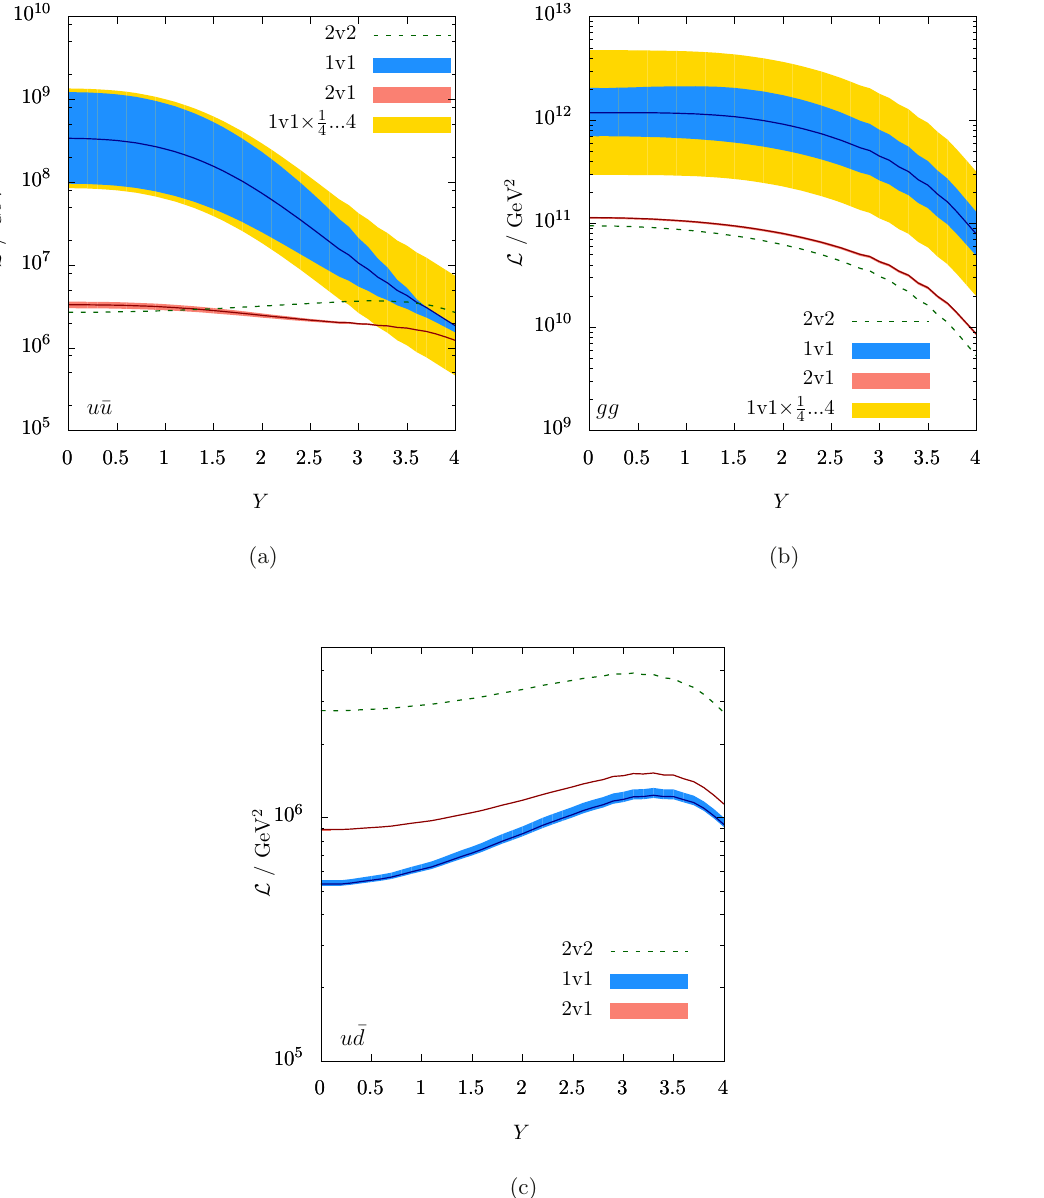
Figure 12 . Double parton scattering luminosities a 1 a 2 b 1 b 2 ( Y ) for the production of two systems L with Q 1 = Q 2 = 80 GeV at √ s = 14 TeV, one with central rapidity and the other with rapidity Y . The parton combinations a 1 a 2 b 1 b 2 are u ¯ u ¯ uu + ¯ uuu ¯ u (a), gggg (b) and u ¯ d ¯ du + ¯ duu ¯ d